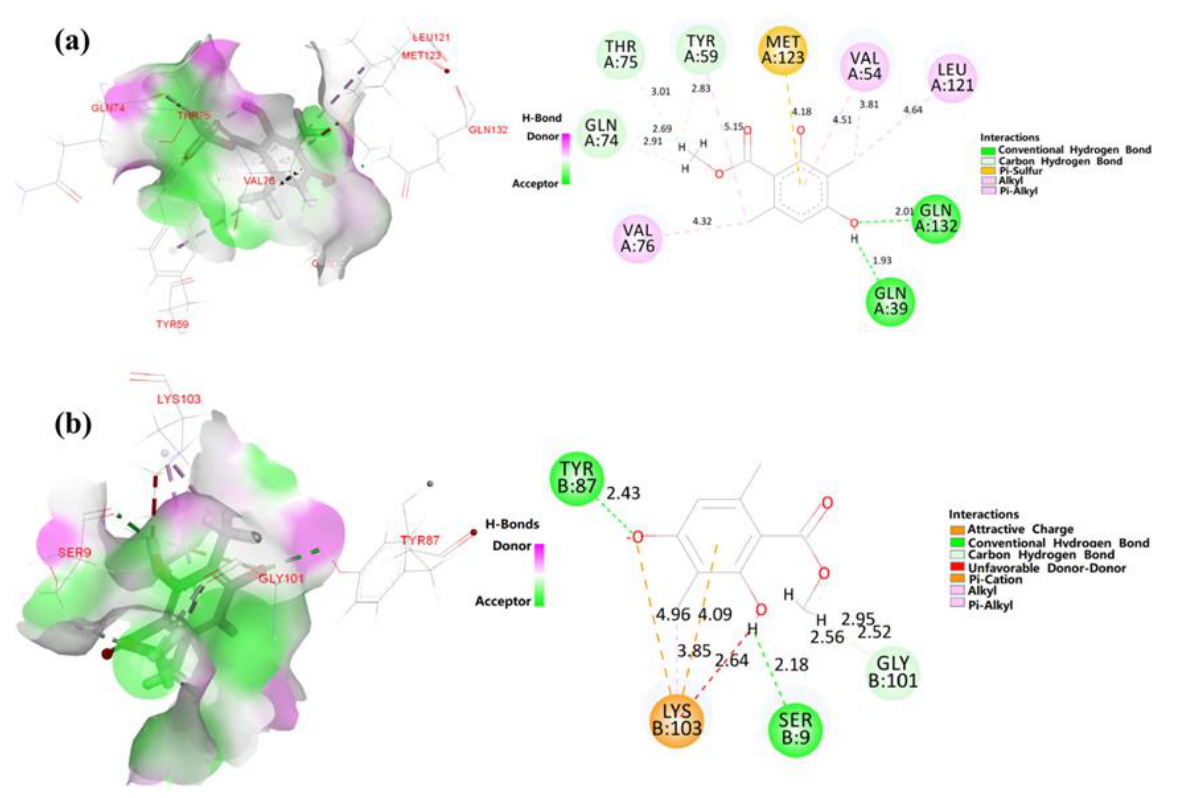
Figure 3. The specific interactions between AA and tyrosinase after automated docking of AA to the tyrosinase enzyme binding site. Predicted 3D structure of the PKA (Protein Data Bank; PDB ID: 4YKO)-AA complex and 2D diagram ( a ). Predicted 3D structure of the CREB (PDB ID: 7KFO)-AA complex and 2D diagram ( b ).